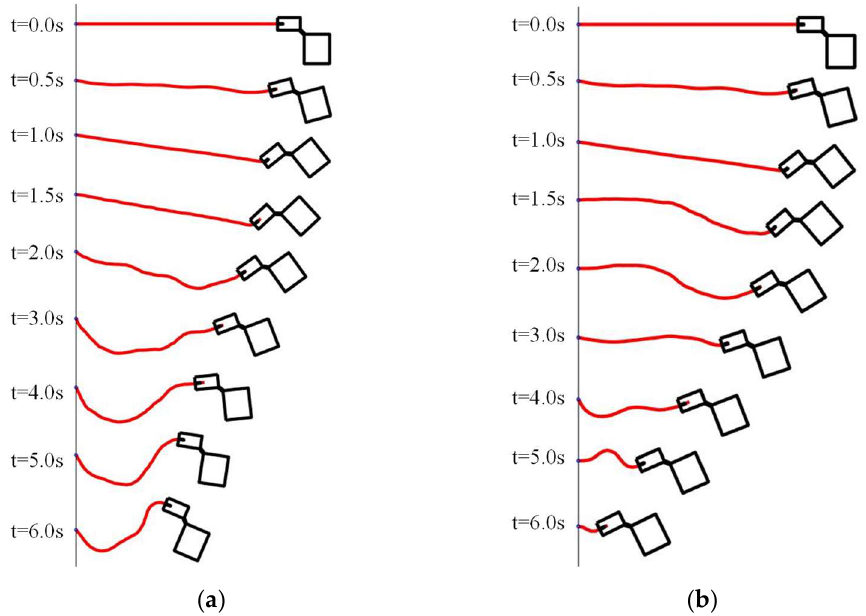
Figure 13. Comparison of system shape. ( a ) Without control; ( b ) With control.